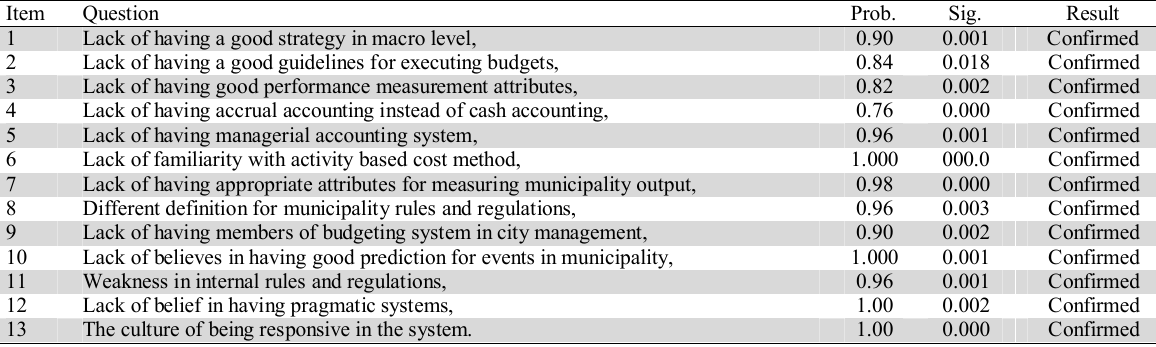
The summary of the responses associated with the first hypothesis